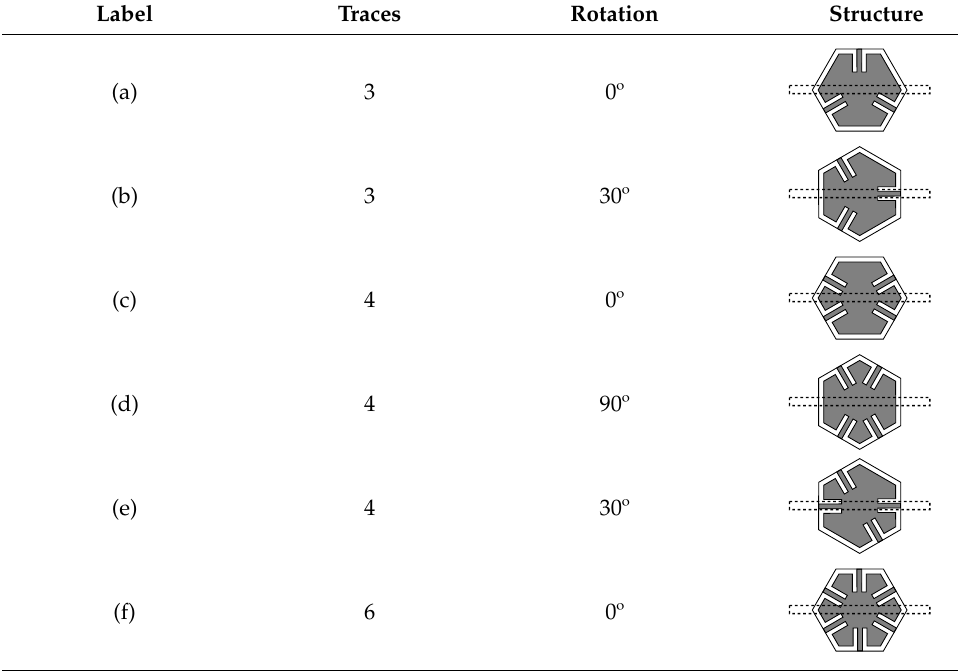
Table 1. Six variations of HCPBG geometries considering rotations and suppressed traces. Label